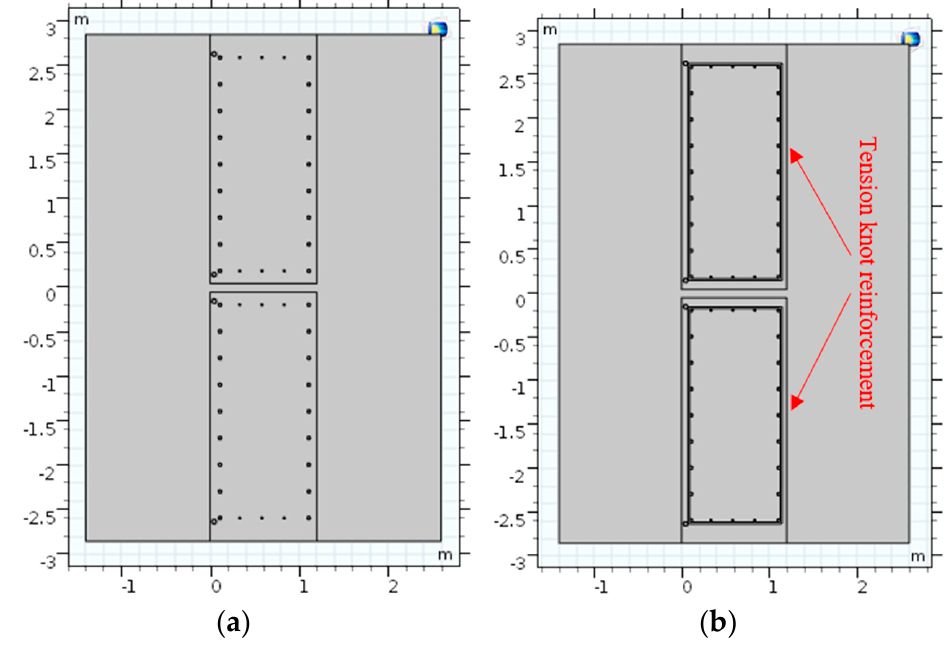
Figure 17. Two-dimensional profile of the model; ( a ) Sectional view of the model without tie bars; ( b ) Sectional view of the model with tie bars.